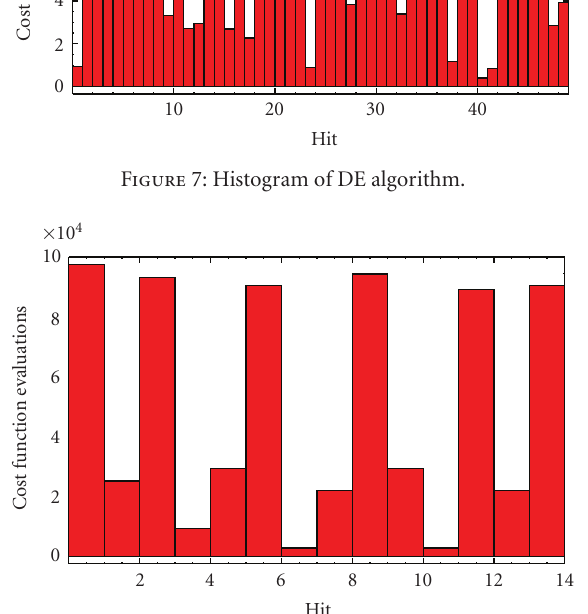
Figure 8: Histogram of SA algorithm.